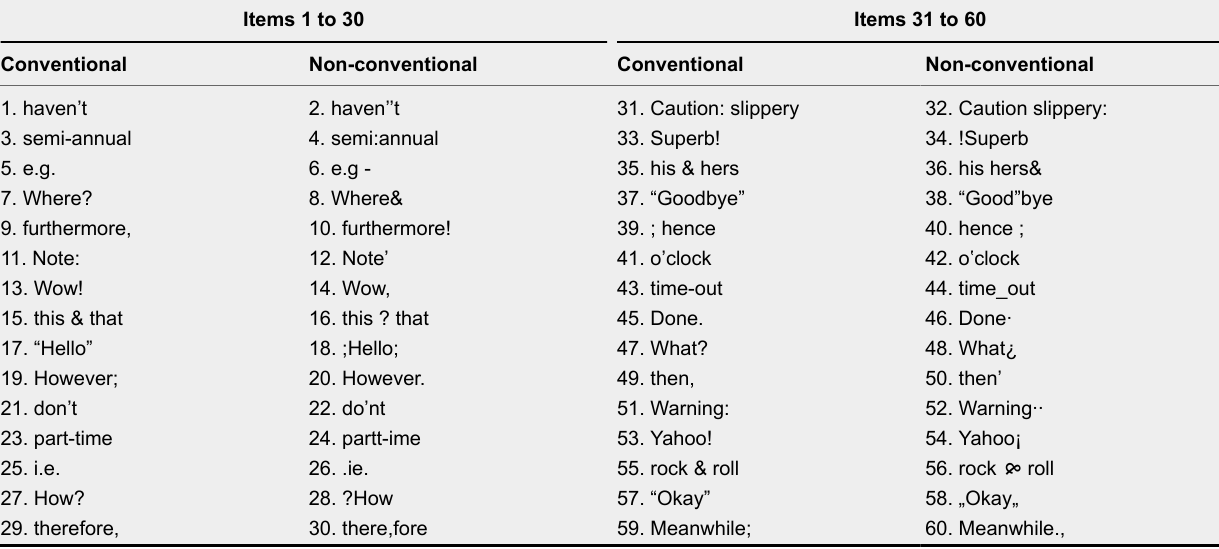
Experimental Stimuli for the Symbol-Decision Task for Punctuation (SDT-Punctuation) Items 1 to 30 Items 31 to